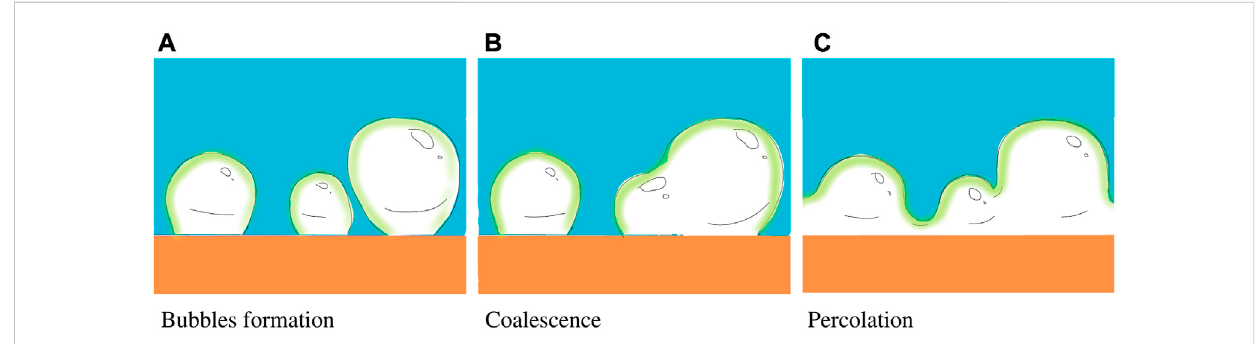
FIGURE 10 Sketch of (A) the nucleation of the vapor bubbles, (B) their random coalescence, leading to the formation and expansion of the vapor channels, and (C) subsequentvaporchannelspercolation.Ifthetimeforchannels ’ percolationissmallerthantheviscoustime t ] ,theconsequentdroprecedingleadsto the drop rebound.